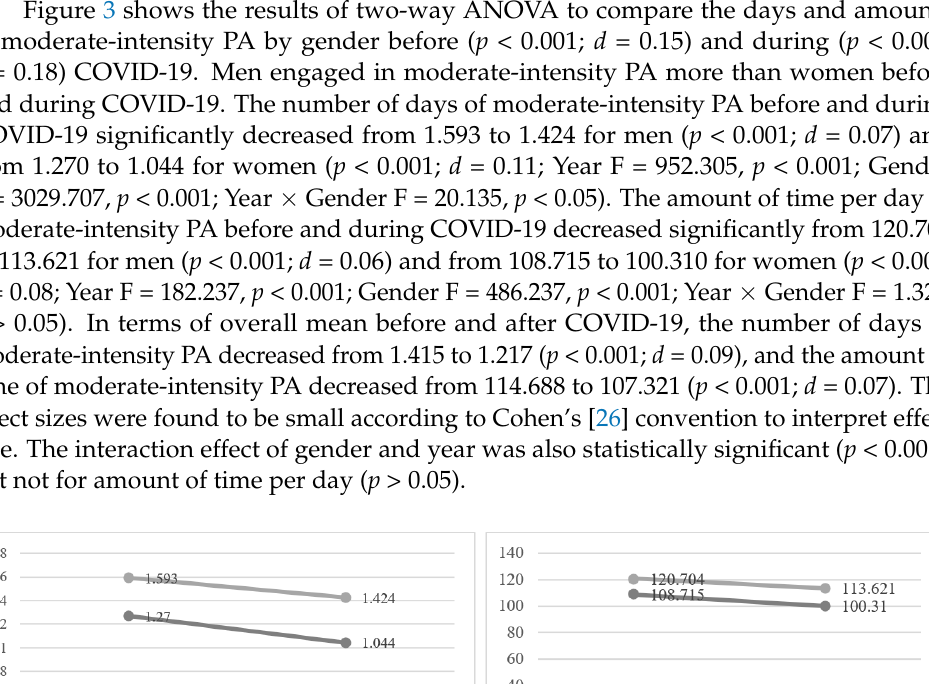
Figure 2. Changes in high-intensity PA by gender before and during COVID-19. Note: Time repre- sents the number of minutes exercised per week.